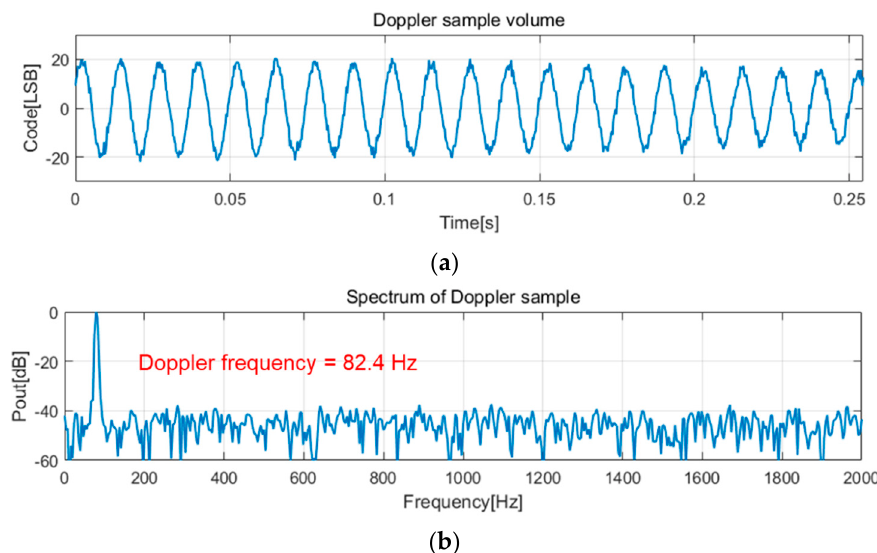
Figure 19. Measured ( a ) Doppler sample volume and ( b ) spectrum from the flow phantom model.